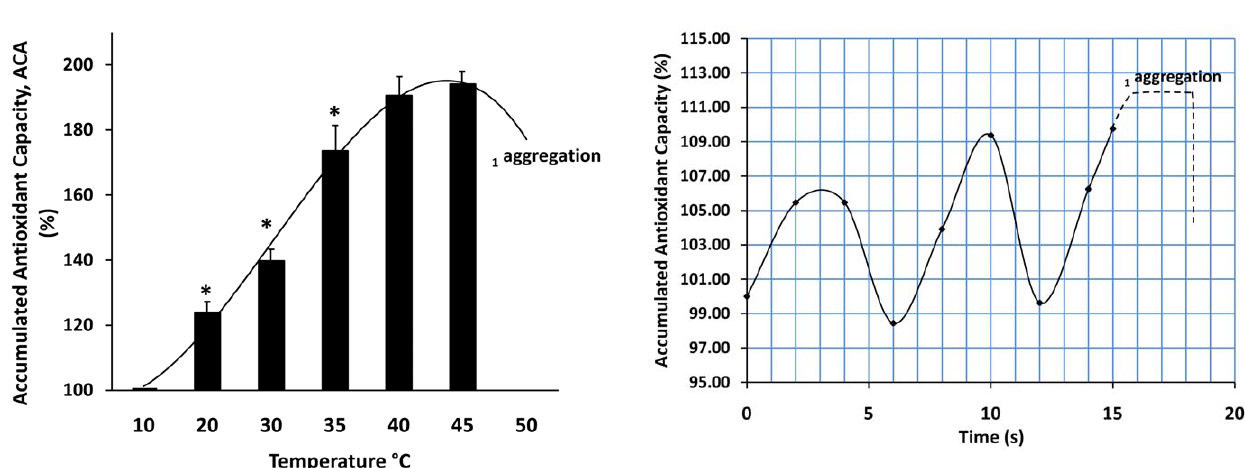
Figure 2. The antioxidant behavior of Human Serum Albumin (HSA) in a pre-denaturation temperature thermal gradient. The Accumulated Antioxidant Capacity (ACA%) appears as a function of the thermal change. Each point corresponds to an independent experiment verified at indicated temperatures. The antioxidant capacity (AC) of the albumin placed at 10 u C was 48 nM TEU and corresponds to 100% of ACA%. From this point the antioxidant capacity of albumin increases with the temperature, until it reaches almost 200% ACA. RS correspond to ACA%-100 as specified in the Material and Methods section. Above 45 u C it is possible to observe protein aggregation and light scattering at 400 nm in the stock solutions. Each point represents the average of three separate experiments 6 SD. All points with a P , 0.001 vs. 10 u C temperature (ACA=100%). *P , 0.001 vs. previous and next point. 1 Temperature for aggregation is concentration-dependent (more details in the text). doi:10.1371/journal.pone.0008971.g002 (Figure 3). We speculate that the fluctuations observed could correlate with a transient fluctuation pattern of structural unfolding and refolding. However, in contrast to the ACA of close to 200% at about 50 u C (Figure 2), the changes observed here never exceed 10% of ACA.